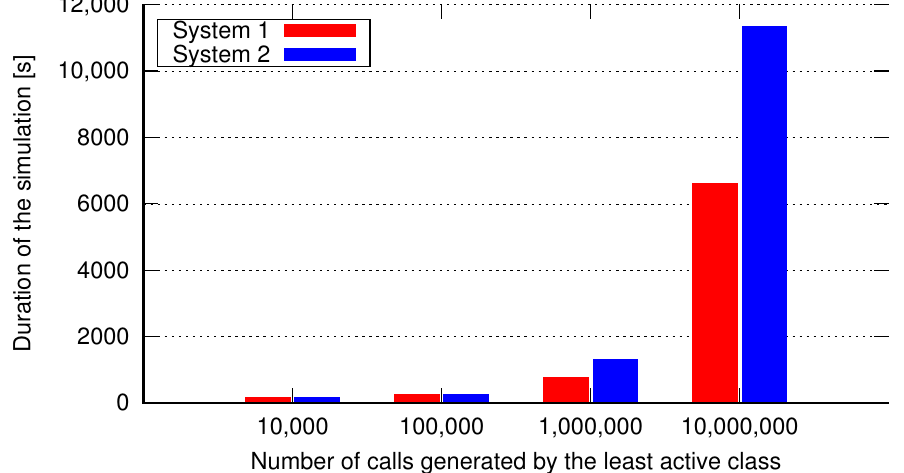
Figure 20. Duration of one simulation run in relation to the required number of generated calls of the least active